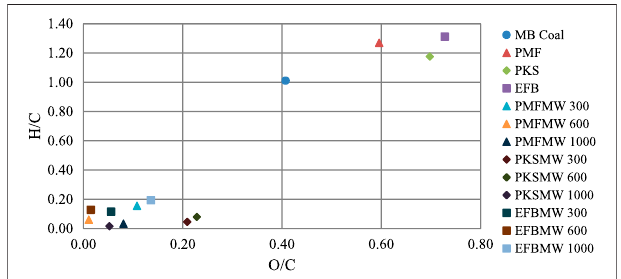
FIGURE 6 | Van Krevelen plot of various solid